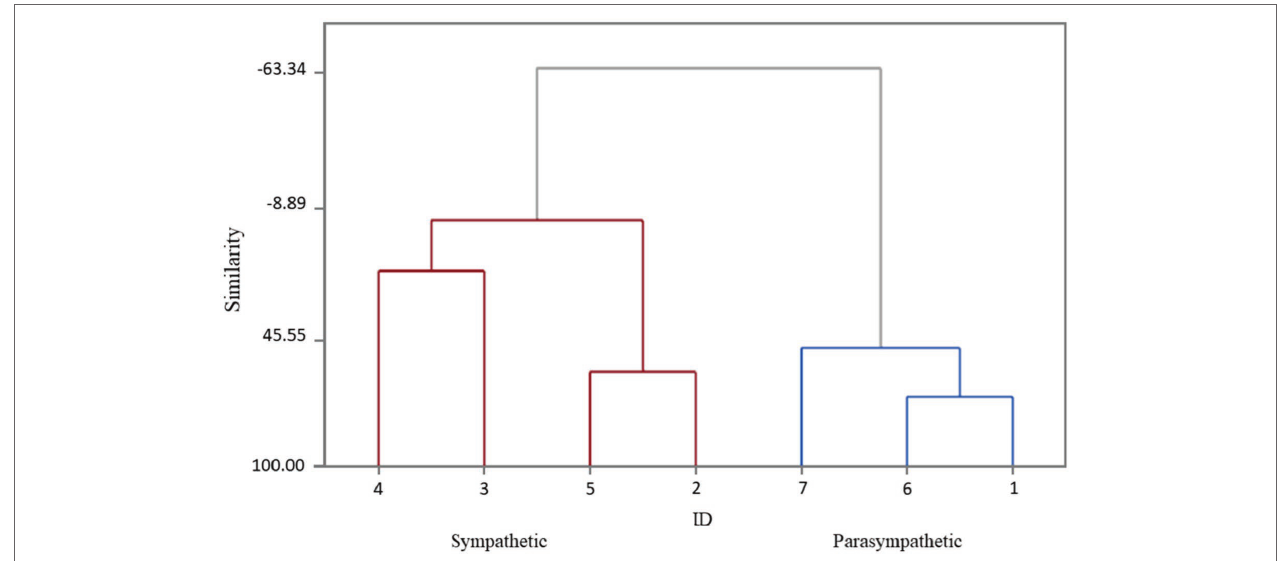
FIGURE 1 | The division of cosmonauts into groups depending on the predominant type of autonomic regulation (Dendrogram Ward Linkage; Euclidean Distance). ID 4; 3; 5; 2 (red line) – cosmonauts with a predominance of sympathetic modulating influences (sympathetic). ID 7; 6; 1 (blue line) – cosmonauts with a predominance of parasympathetic modulating influences